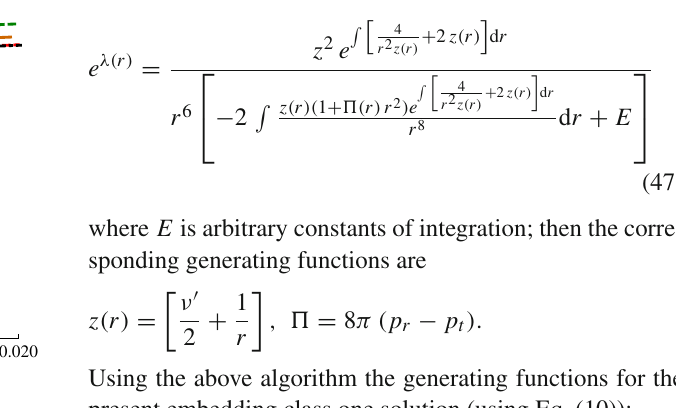
Fig. 12 Behaviour of mass ( M (cid:7) ) vs. central density ρ 0 ( 0 − 2 . 6993 × 10 15 g/cm 3 ) for the different compact